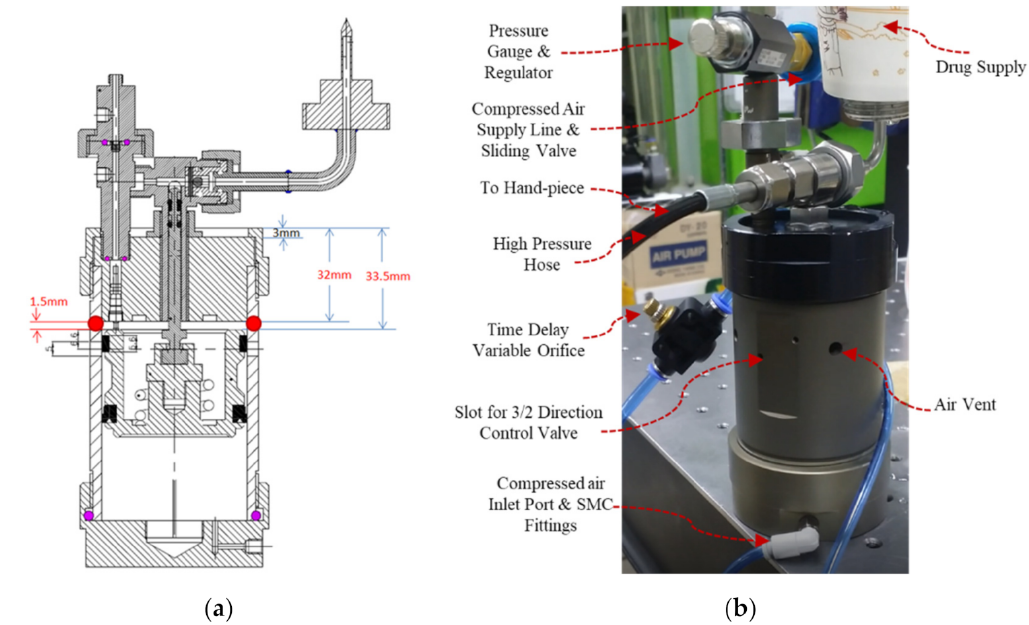
Figure 9. ( a ) Dimensions of a pressure intensifier for air-vent drilling in the body, and ( b ) the injection volume measurement experimental setup for 170 cP liquid silicon